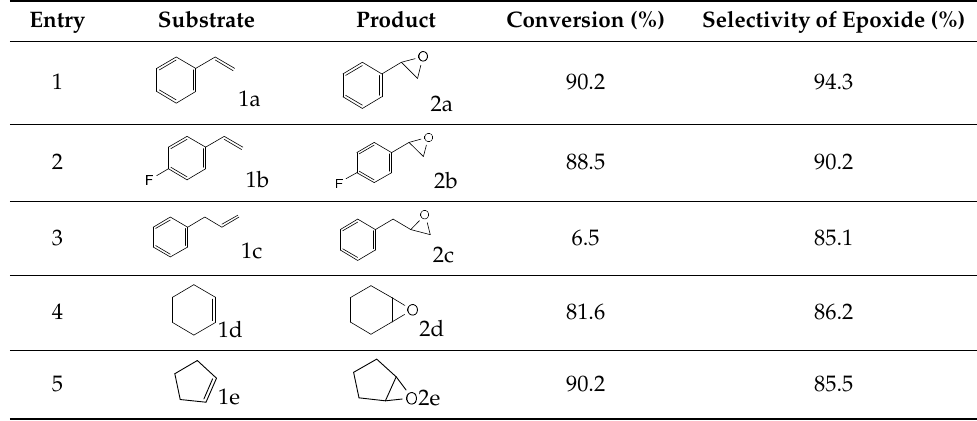
Table 3. Mn 0.1 Cu 0.9 -MOF catalyzed epoxidation of various substrates by H 2 O 2.